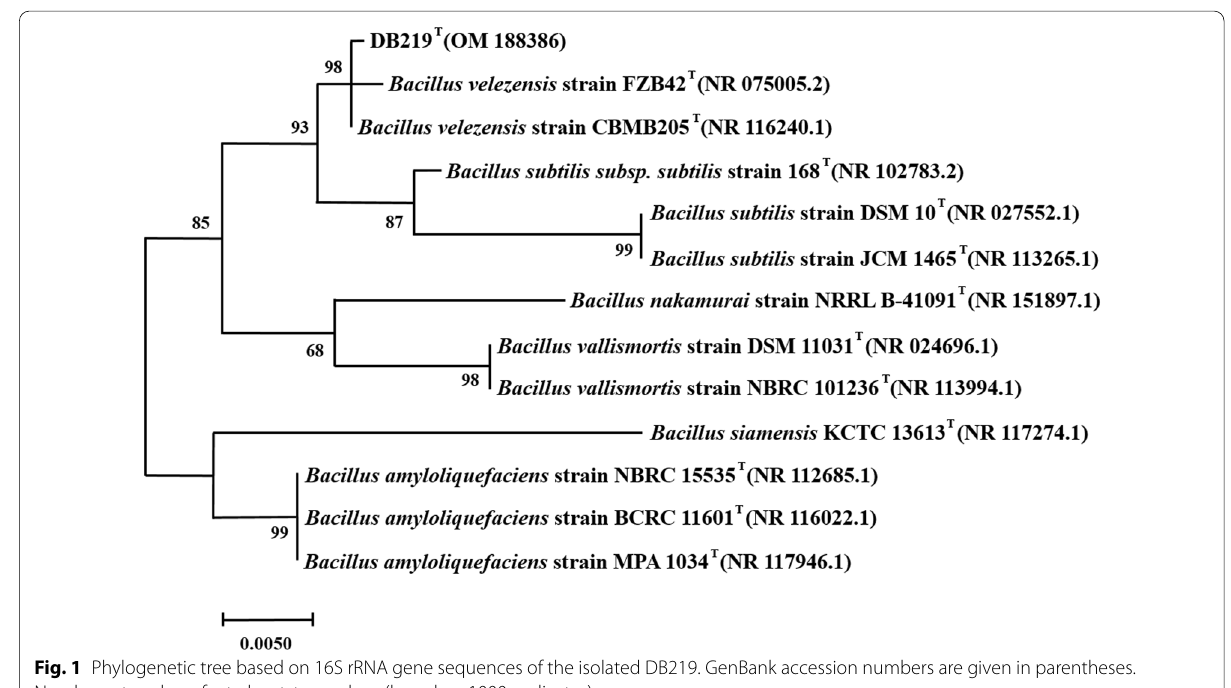
Fig. 1 Phylogenetic tree based on 16S rRNA gene sequences of the isolated DB219. GenBank accession numbers are given in parentheses. Numbers at nodes refer to bootstrap values (based on 1000 replicates)